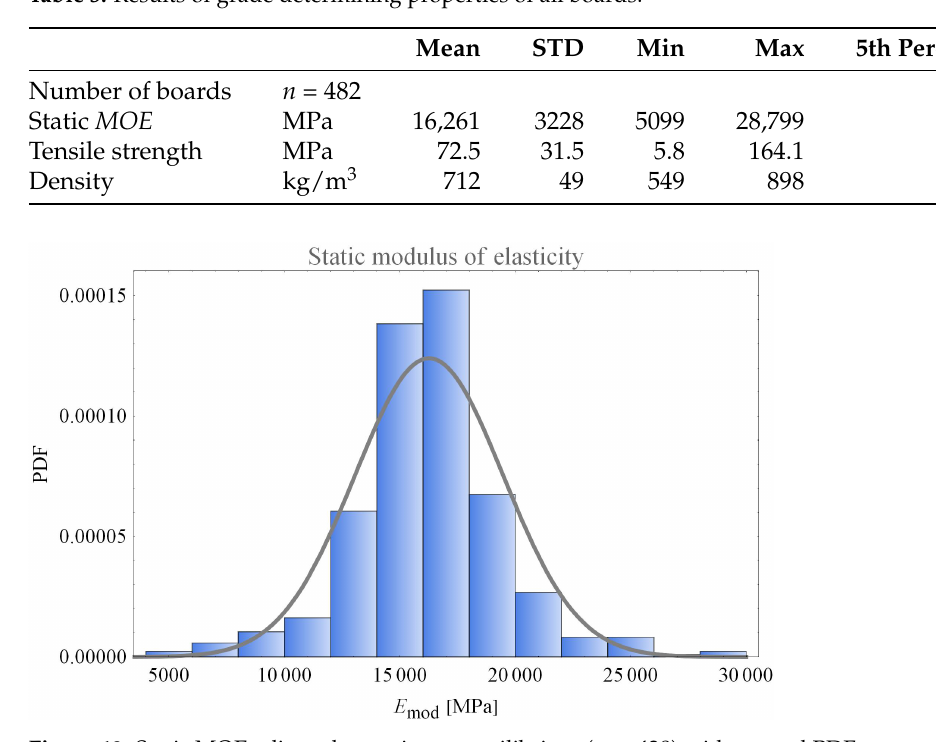
Figure 13. Static MOE adjusted to moisture equilibrium ( n = 428) with normal